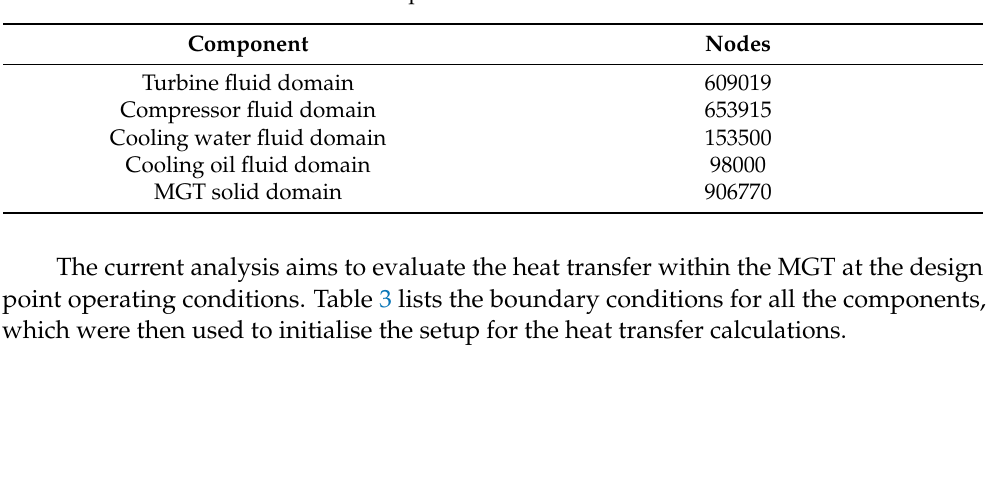
Table 2. Mesh statistics for the MGT